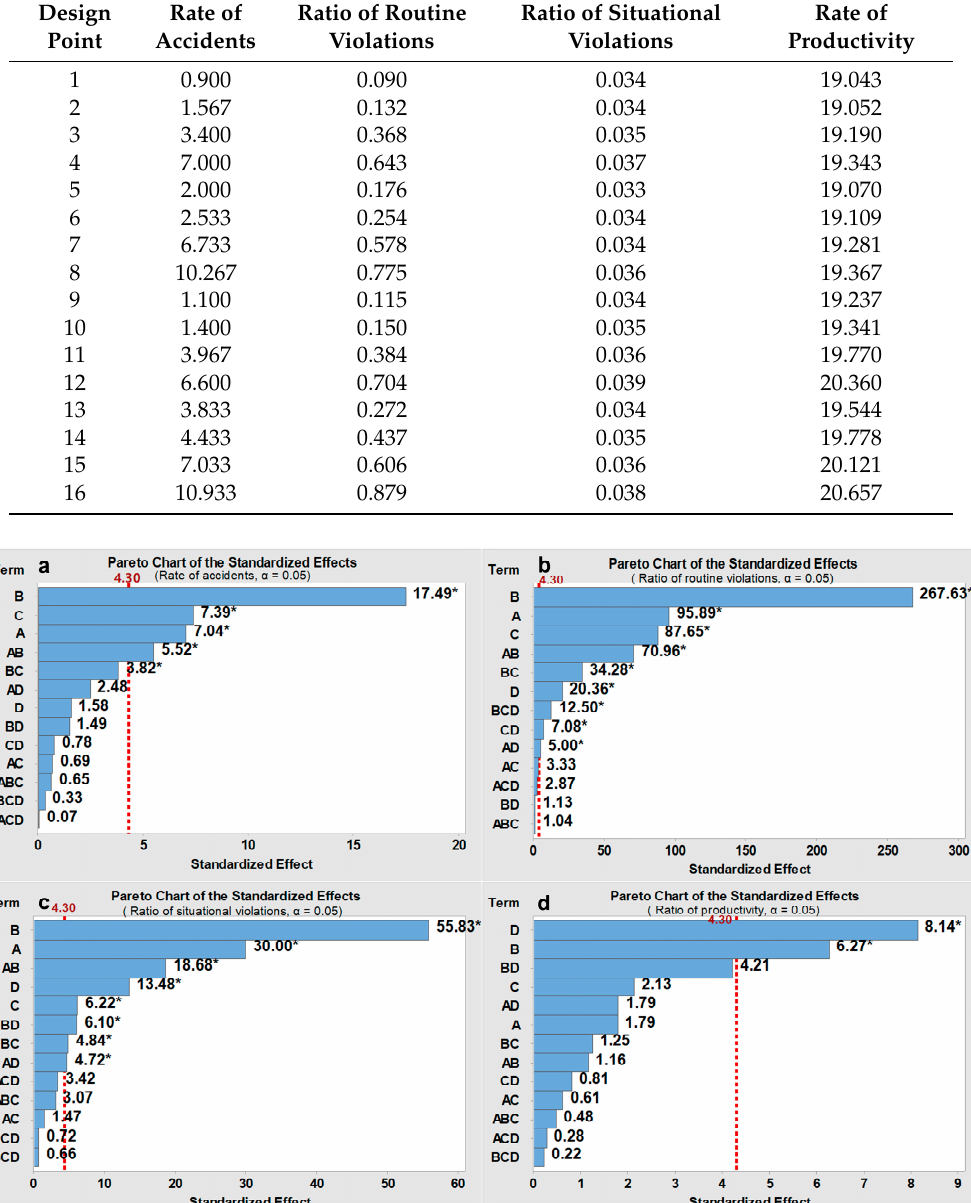
Table 8. Average response variables for the “low” hazard onsite condition.